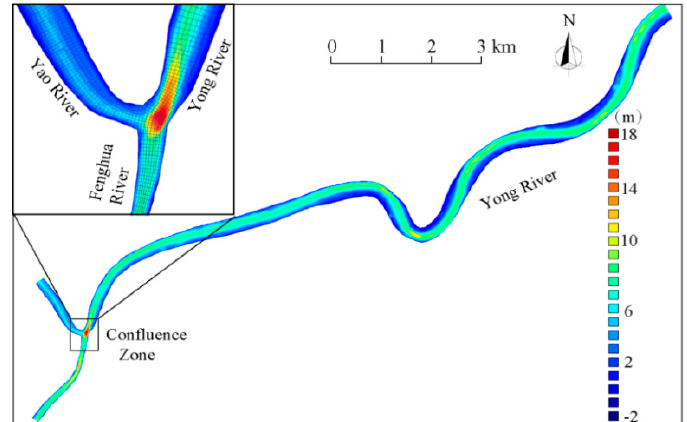
Figure 6. Bathymetry of the study area with confluence.